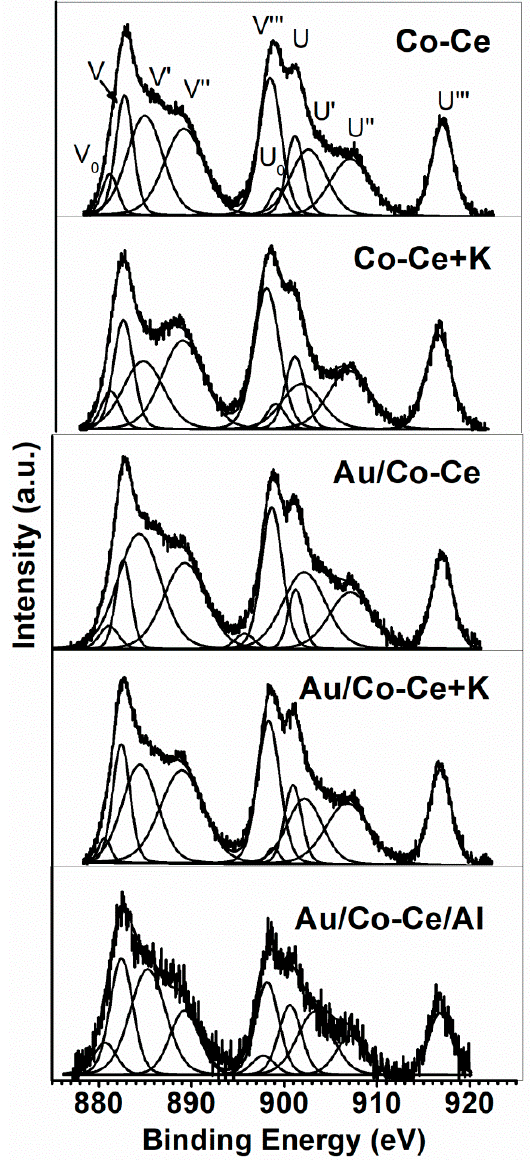
Figure 6. Ce 3d XP spectra of the studied samples.